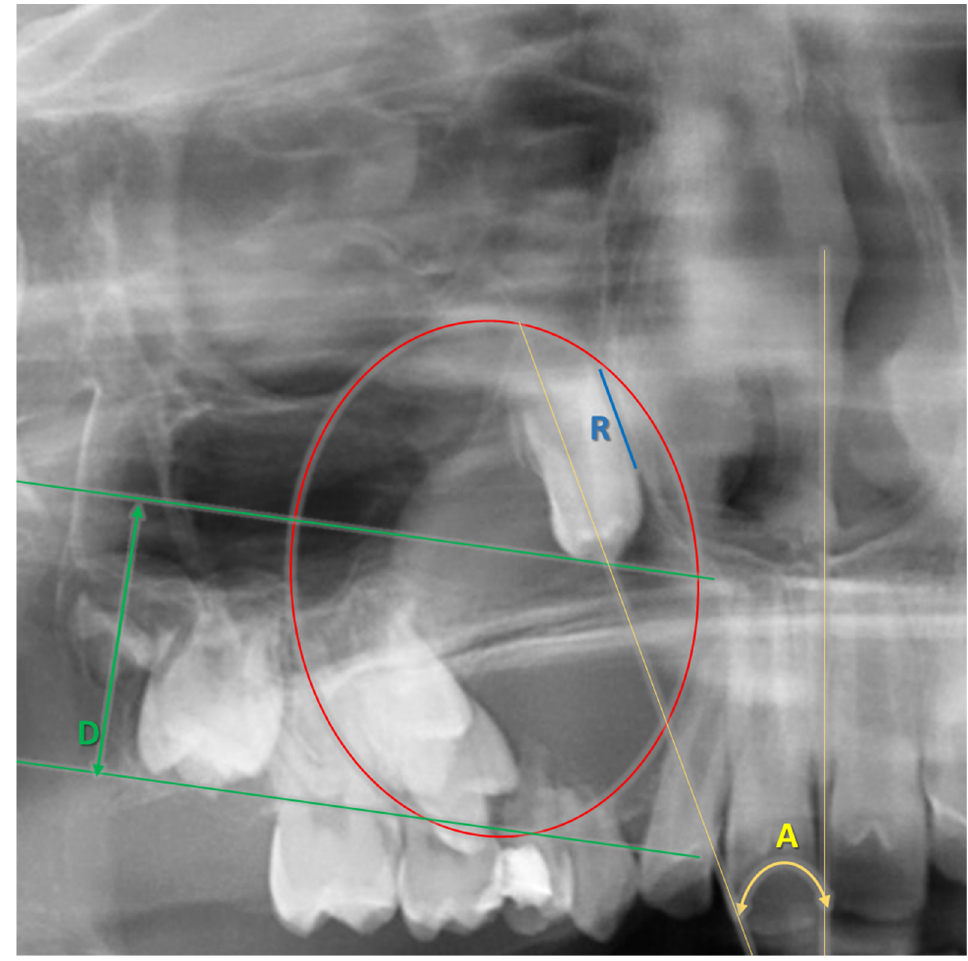
Figure 15. Factors determining the chance for spontaneous eruption after marsupialization A—an- gulation; D—depth of cusp; R—root